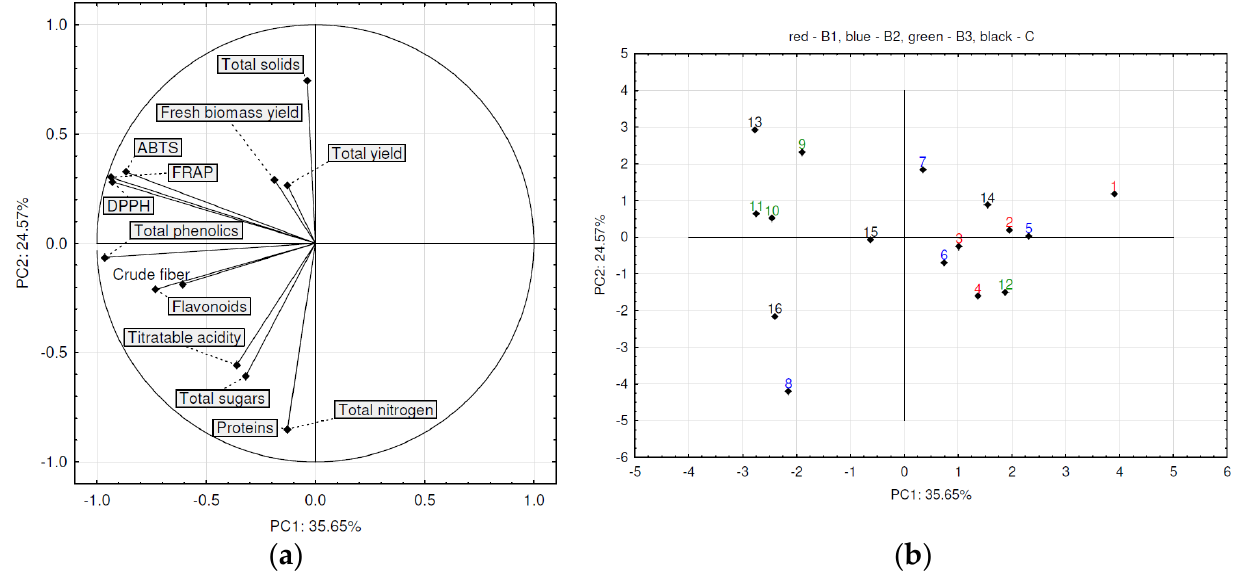
Figure 4. PC1-PC2 presentations as a result of PCA of onion samples deriving from 16 treatments of directly seeded (DS) onion: ( a ) loadings and ( b ) scores plot. Legend: 1, no 2 in appendix A; 2, no